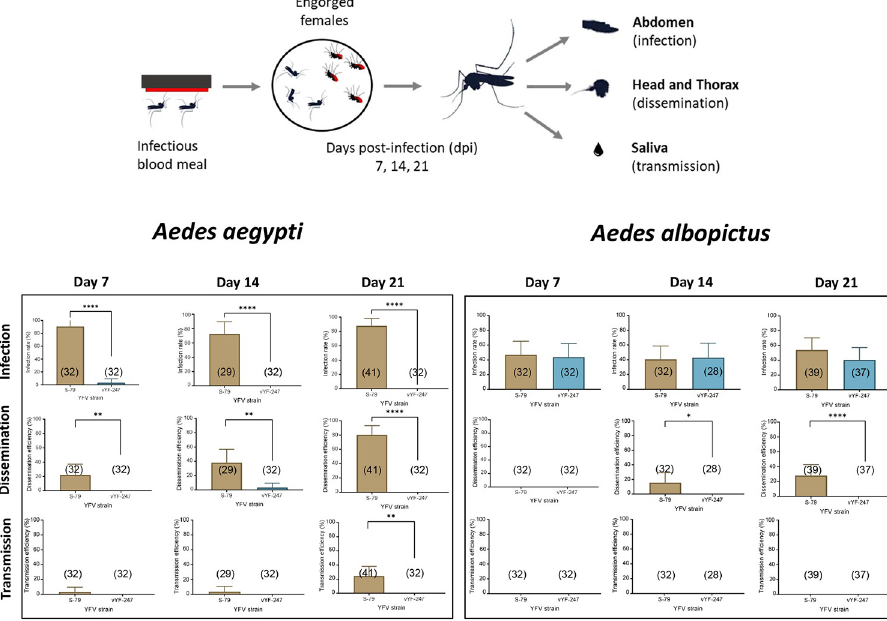
Fig 1. Infection rate, dissemination efficiency, and transmission efficiency of Aedes aegypti AAPAEA and Aedes albopictus ALPROV exposed to vYF-247 and S-79 strains. Mosquitoes were presented to a blood meal provided at a titer of 10 7.5 ffu/mL and examined at 7, 14, and 21 days post-infection. In brackets, number of tested mosquitoes. Stars indicate statistical significance of comparisons by Fisher’s exact test: � p � 0.05, �� p � 0.01, ���� p � 0.0001.